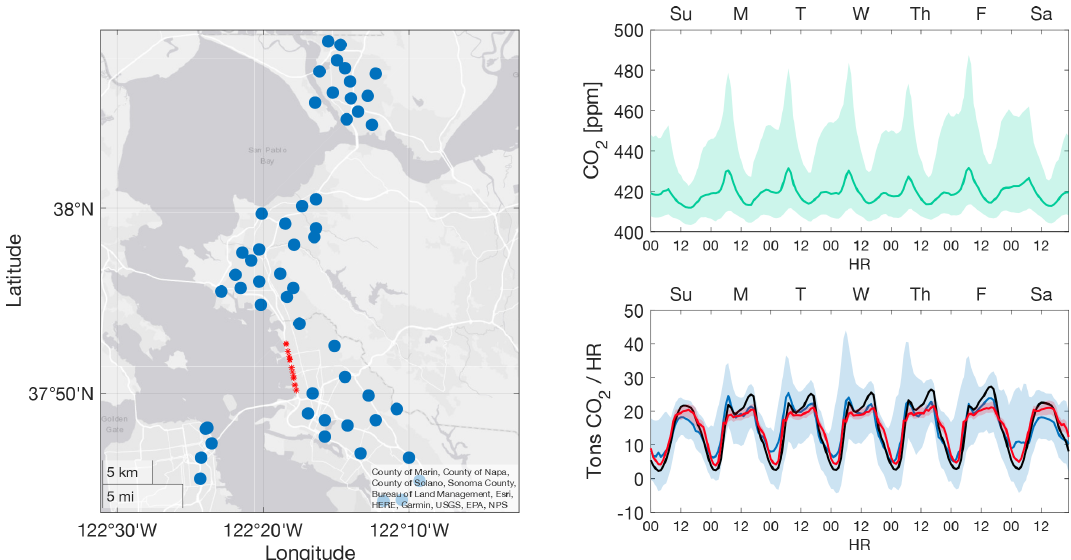
Figure 1. The left panel presents a map of the BEACO 2 N network, showing all sites (blue dots) for which there are more than 4 weeks of data during the period analyzed (January to June from 2018 to 2020). Red stars indicate the location of the PeMS monitors used in this study. The top right panel presents CO 2 values shown for a “typical week” during the time period observed. The dark line represents the median value observed across all sites and times, and the shaded envelope represents 1 σ variance across the network and over the 2-year period. The bottom right panel presents CO 2 emissions on all highway pixels in the domain as derived from the inversion of BEACO 2 N observations (blue), BEACO2N prior (black), and the PeMS-EMFAC-based estimate (red). The shaded envelope shows variance in emissions during the 18-month analysis